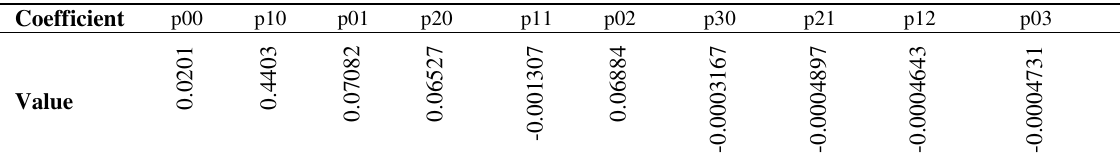
Coefficients of Polynomial of the Second Case Study (Dome).